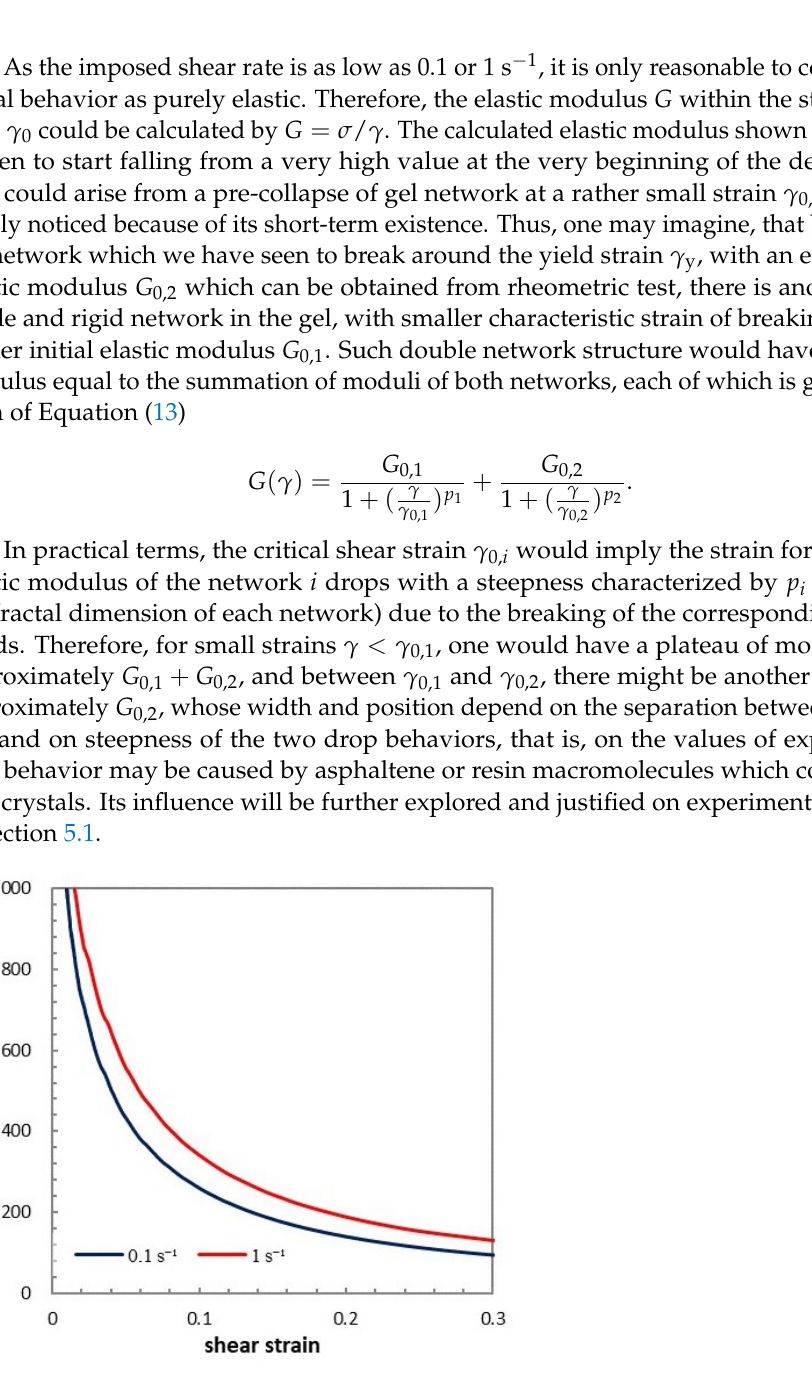
Figure 4. Shear modulus dependence on shear strain G ( γ ) in the early stage of yielding, obtained from the experimental data of σ and γ in Figure 1a by appling G ( γ ) = σ ( γ ) / γ